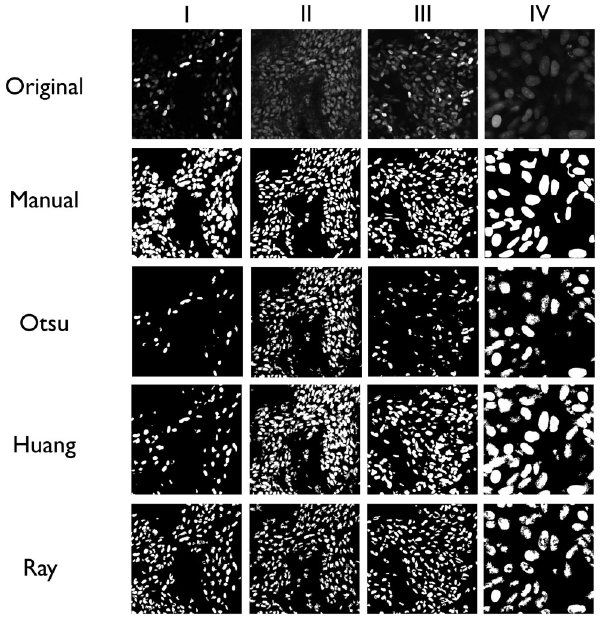
Figure 1. A diverse set of typical intravital images was analyzed using different thresholding methods to determine their suitability for cell segmentation across a variety of conditions. Cell nuclei are shown at various magnifications labeled with H2B-Apple. I. An image displaying multiple fluorescent brightness levels. II. A dense cell field image. III. A dense cell field with multiple fluorescent brightness levels. IV. A high magnification image with intracellular details. The techniques analyzed were: manual threshold- ing, Otsu’s method, Huang’s method, and Ray’s method.